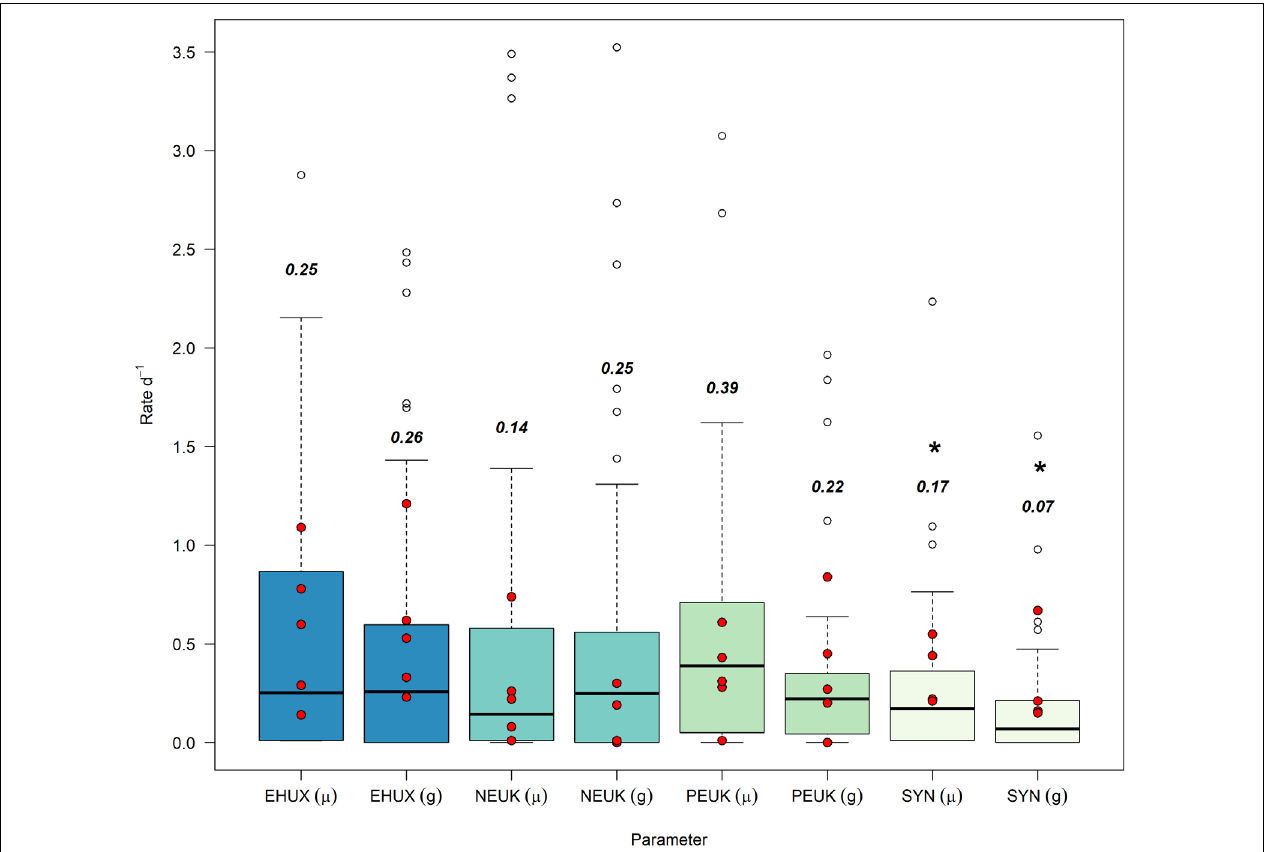
FIGURE 1 | Growth ( µ ) and grazing (g) rates (d − 1 ) from all mesocosm experiments, separated by analysis groups. Bold text represents the median values, unfilled points are outliers that are still included in data analysis, and asterisks (*) are groups that have rate distributions that are significantly different from E. huxleyi . Red overlaid dots are from non-mesocosm field experiments from Mayers et al. (2018) in the Celtic Sea (Northwest European Shelf). EHUX, E. huxleyi ; NEUK, nanoeukaryotes; PEUK, picoeukaryotes; SYN, Synechococcus